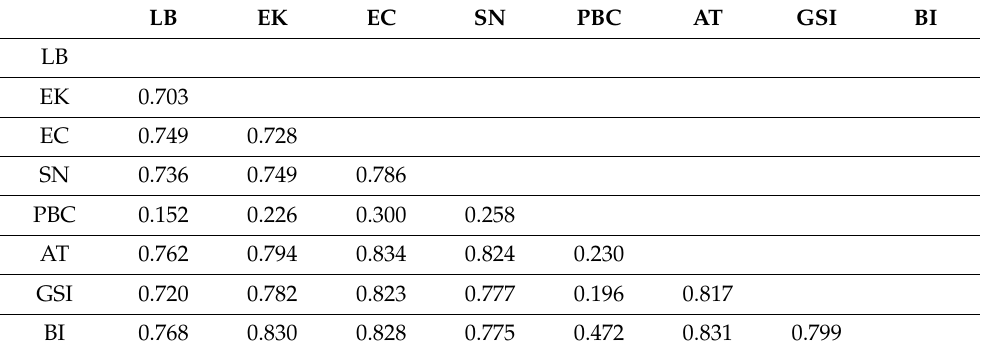
Table 5. Discriminant Validity using Heterotrait-Monotrait Ratio (HTMT).